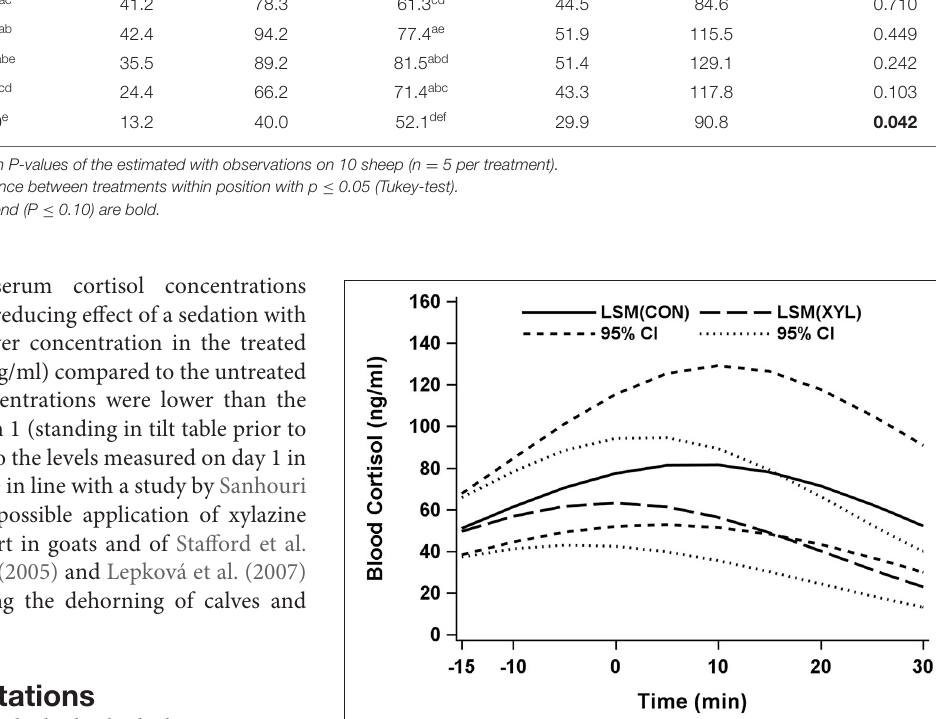
TABLE 8 | Treatment (CON, XYL) comparison at different positions for the blood cortisol concentrations. Position LSM XYL 95% CI